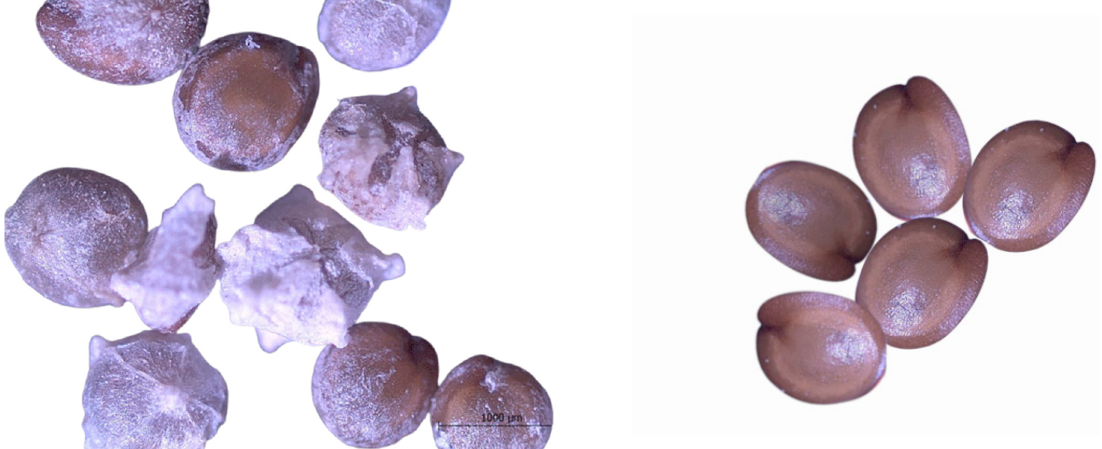
Figure 2. Canihua, whole grain ( left ), and dehulled grain ( right ), bar 1000 µm. Each sample was milled (Retsch, ZM 200, Hann, Germany) at <0.5 mm and <1 mm for chemical and mineral analyses. The obtained fl ours were packaged and stored at 4 °C until further